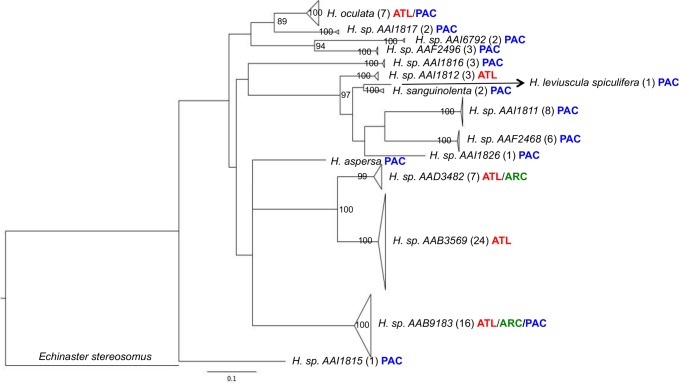
Deep divergences at COI within Henricia.Maximum-likelihood tree (GTR+G+I) for 16 putative species of Henricia. Locality information is provided for each lineage (Atl = Atlantic, Arc = Arctic, Pac = Pacific) and sequence number is presented in brackets for each clade. Scale bar represents percent sequence divergence.